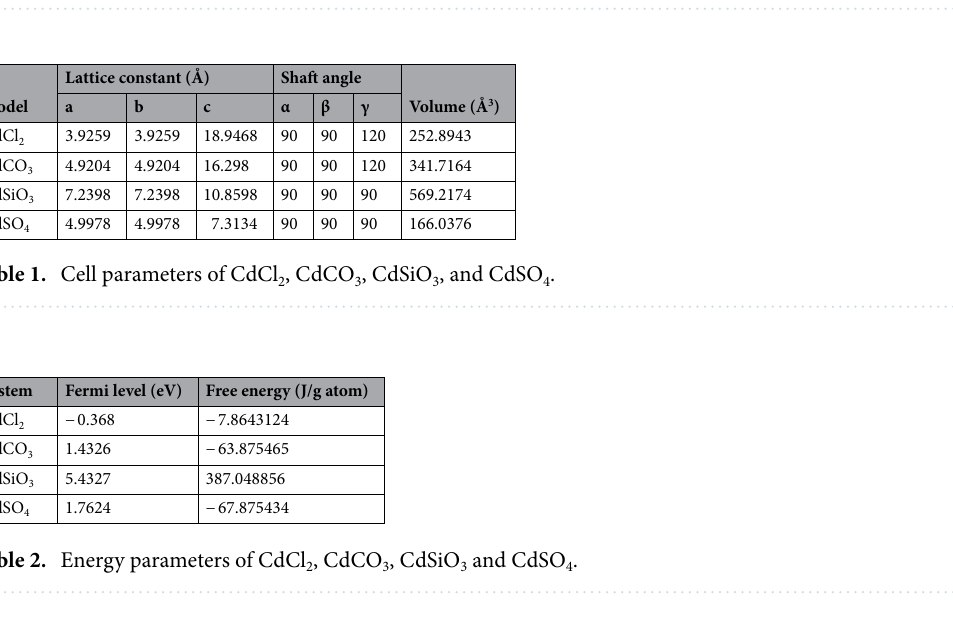
Figure 1. Cell structure of CdCl 2 , CdCO 3 , CdSiO 3 , and CdSO 4 .